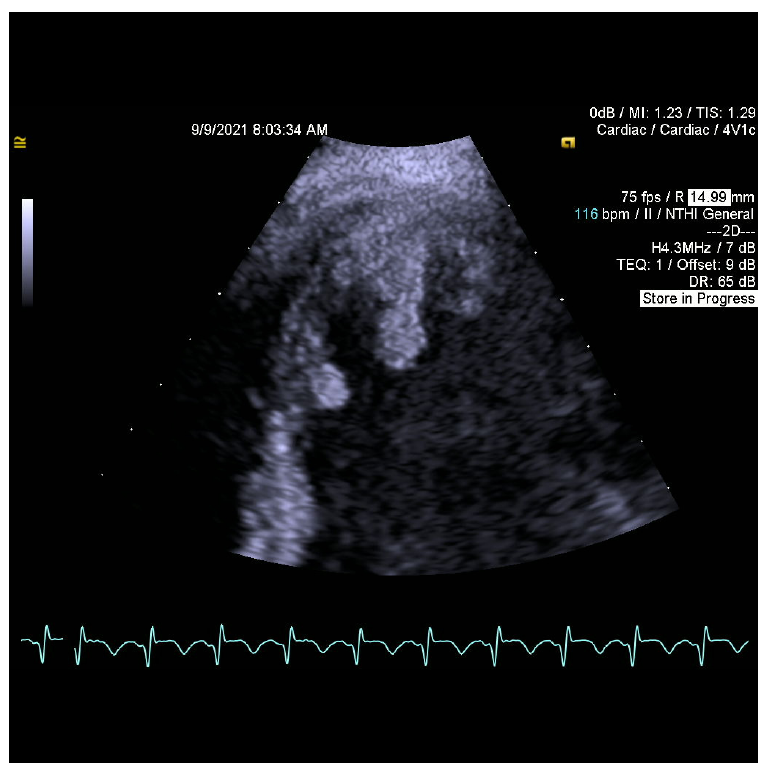
Figure 1. Thrombi in the left ventricular apex with high embolic potential. J. Clin. Med. 2022 , 11 , x FOR PEER REVIEW